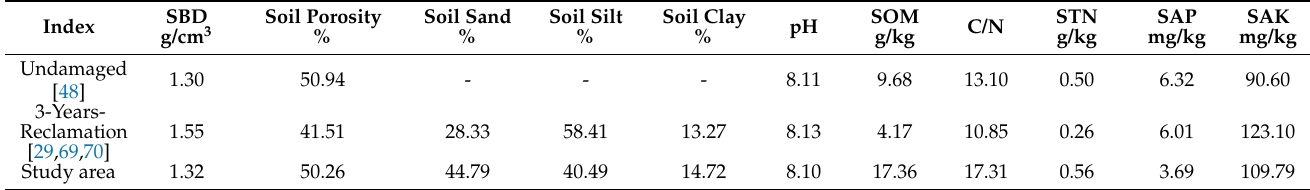
Table 4. Average soil physicochemical properties at 0–20 cm in the study area, and those reported by other